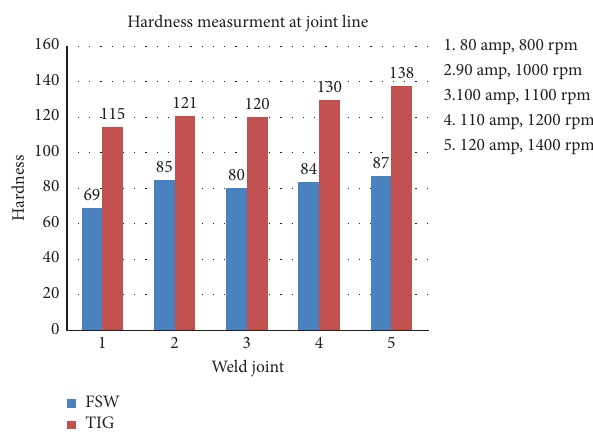
Figure 7: Microhardness at joint line of weldments.